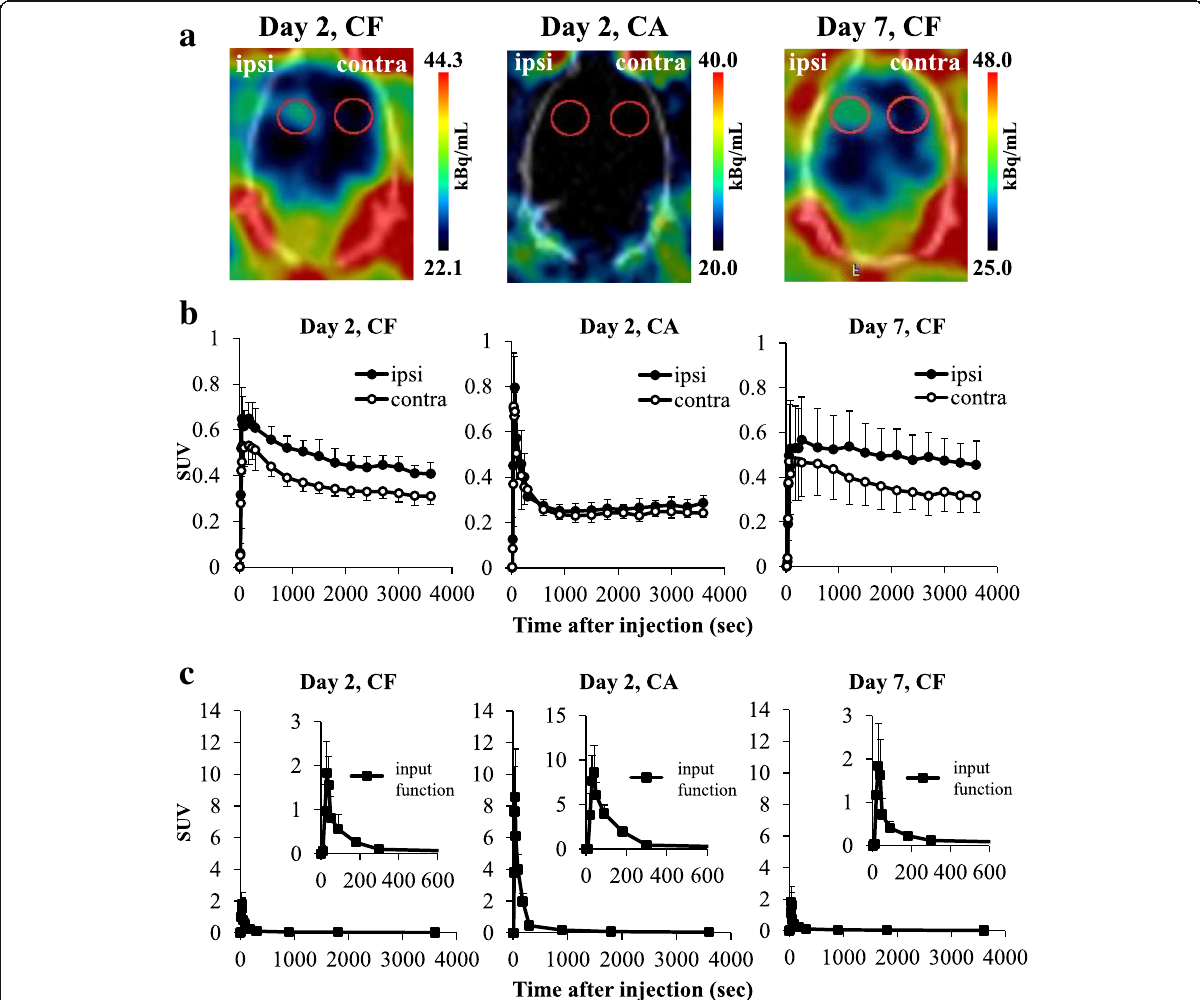
Fig. 7 Typical [ 18 F]DPA-714 PET images and time activity curves in the striatum. a Typical horizontal summed PET images of 20 – 60-min scans at days 2 and 7 after 20-min middle cerebral artery occlusion (MCAO). The left side of each image is the ipsilateral side. These images including the VOIs (red circles) show screen captures from PMOD. b The time activity curves of the VOI placed on the ipsilateral or the contralateral striatum of 20-min MCAO rats injected with [ 18 F]DPA-714 at day 2 (CF: n = 5) and day 7 (CF: n = 4) or [ 18 F]DPA-714 following unlabeled ( R, S )-PK11195 (3 mg/ kg) at day 2 (CA: n = 5). c Metabolite-corrected plasma radioactivity (input function) of 20-min MCAO rats injected with [ 18 F]DPA-714 at day 2 (CF, n = 5) and day 7 (CF: n = 4) or [ 18 F]DPA-714 following unlabeled ( R, S )-PK11195 (3 mg/kg) at day 2 (CA: n = 5). Graphs show SUV, with values expressed as mean ± SD. *CF: A group of rats was injected [ 18 F]DPA-714 only. **CA: A group of rats was injected [ 18 F]DPA-714 and an excess of